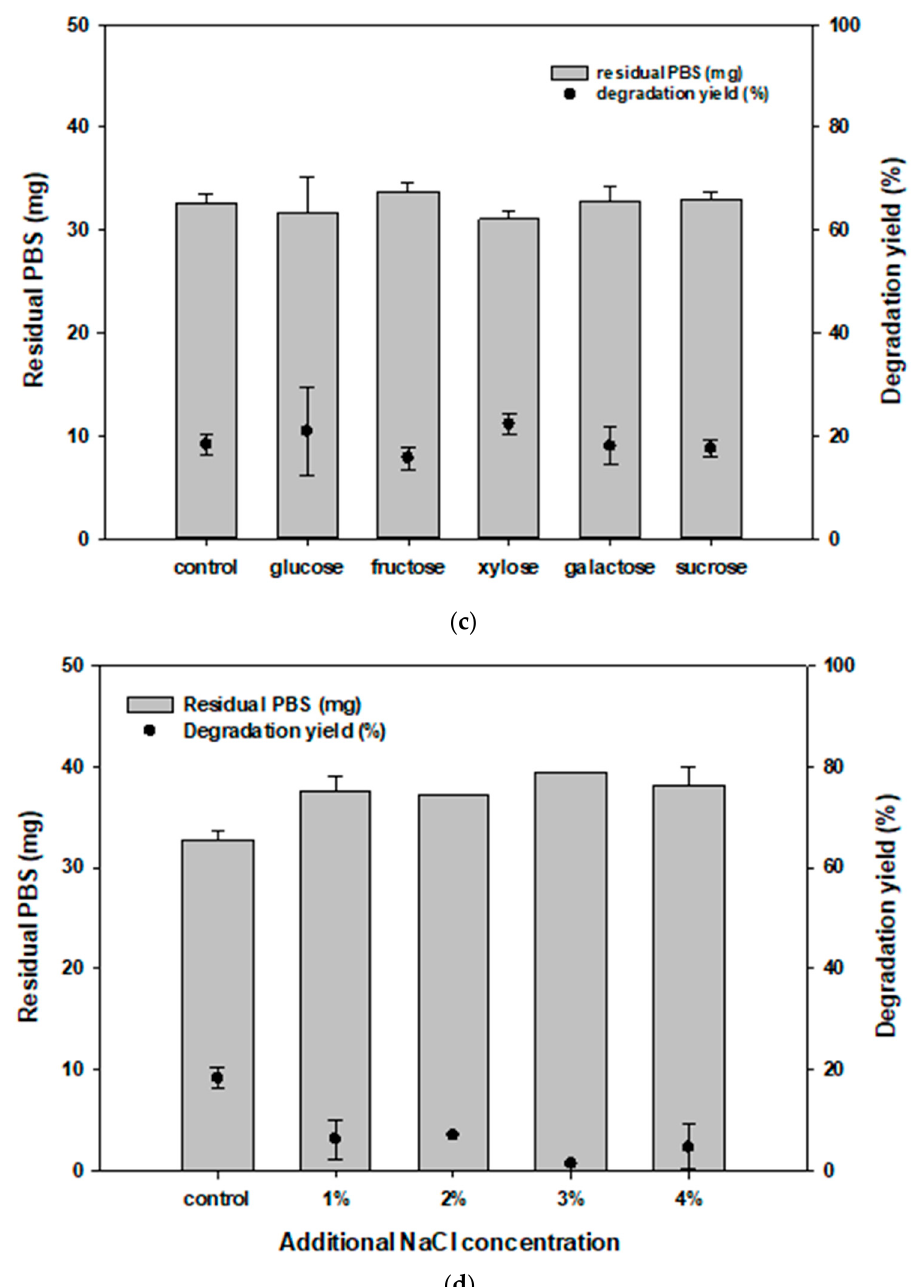
Figure 3. Optimizing the conditions for degrading PBS. ( a ) The changes in clear zone size at different temperatures (20 °C, 30 °C, 37 °C, 42 °C). ( b ) The results of GC-MS analysis to compare the amounts of residual PBS and degradation yield according to temperatures. ( c ) Five different carbon sources (glucose, fructose, xylose, galactose, and sucrose) were used to compare their effect on degradation at 30 °C using GC-MS. ( d ) Comparison of degradation yield according to salt concentration at 30 °C.